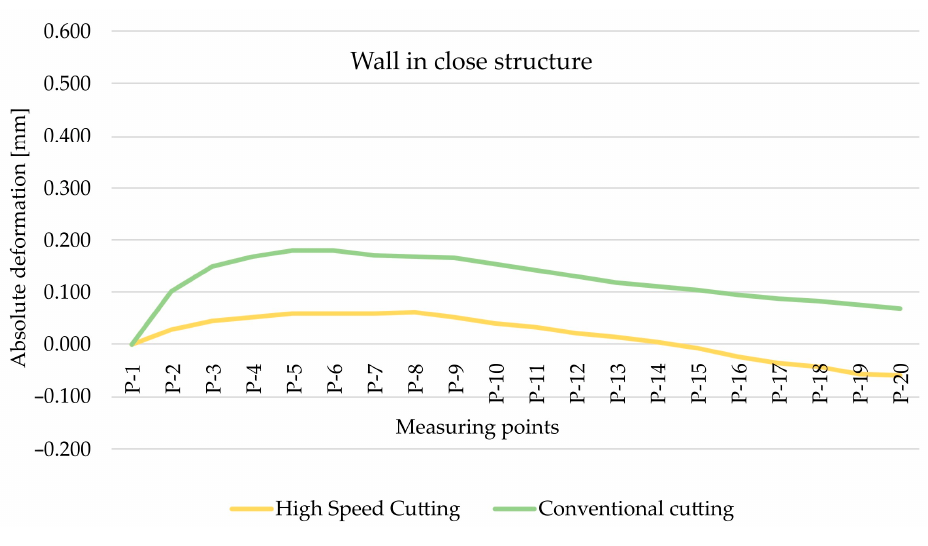
Figure 9. The comparison of absolute deformation for individual measurement points depending on the geometry of the thin-walled sample for conventional cutting and for the EN AW-7075 T651 aluminium alloy.